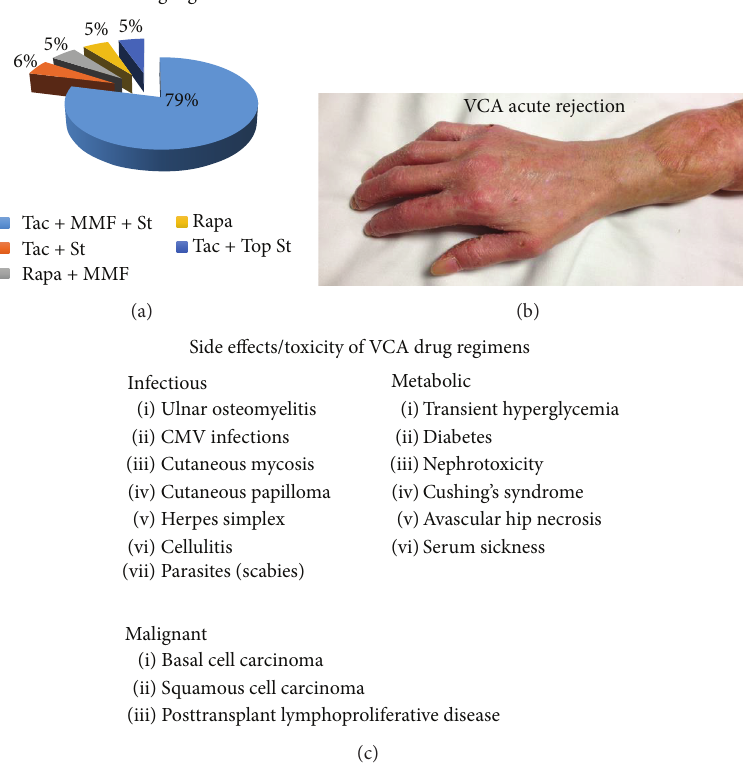
Figure 1: Limitations associated with VCA: Limitations and complications currently associated with VCA include (a) the lifelong need for high dose, multidrug immunosuppressive medications, (b) acute (and chronic) VCA rejection, and (c) side effects and toxicity of antirejection therapies. Patient noncompliance is the main cause of graft loss. Tac: tacrolimus, MMF: Mycophenolate mofetil, Rapa: Rapamycin, St: Steroid, and Top: